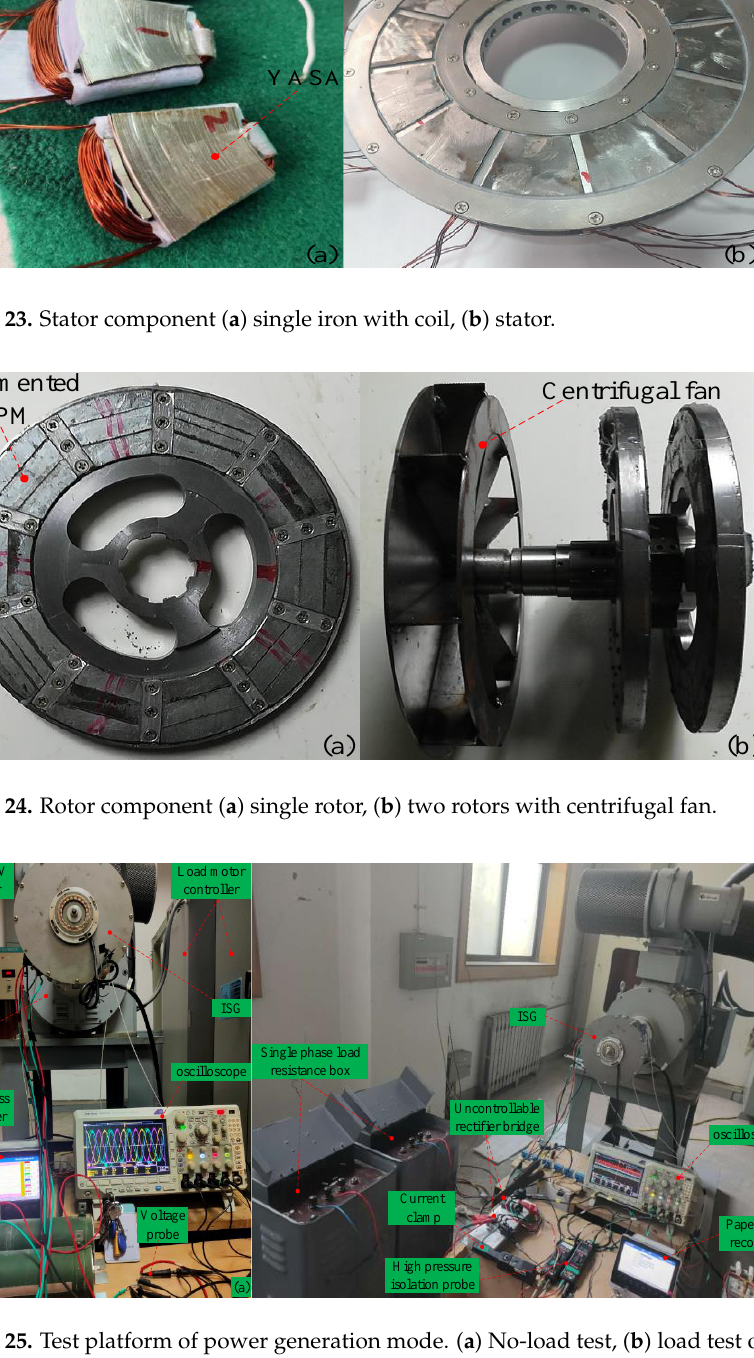
Figure 26. No-load back-EMF wave of axial-flux ISG at different speeds. ( a ) speed n = 1000 rpm, ( b ) speed n = 3000 rpm. Uncontrolled rectifier power generation experiment with R = 65 Ω load resistance is established to calculate output power. We can find that output powers are P n = 230.2 W at n = 1000 rpm in Figure 27a and P n = 2.2 kW at n = 3000 rpm in Figure 27b.